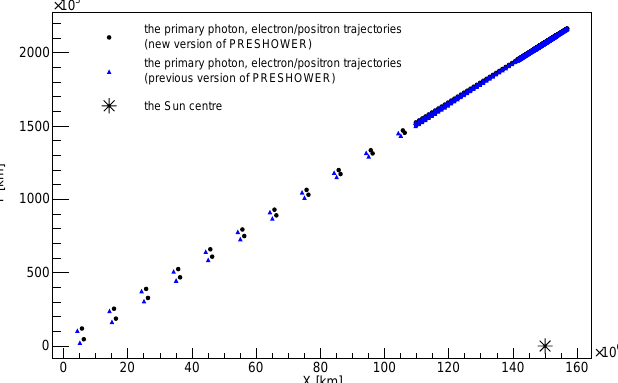
Figure 3. Comparison of particle (the primary photon and the positron–electron pair) propagation in the previous and modified version of PRESHOWER, for the exemplary simulation with the primary photon energy 100